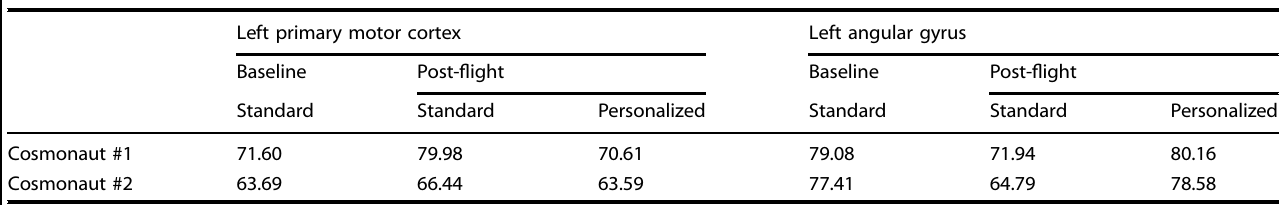
Table 1. NormE values resulted from standard and personalized